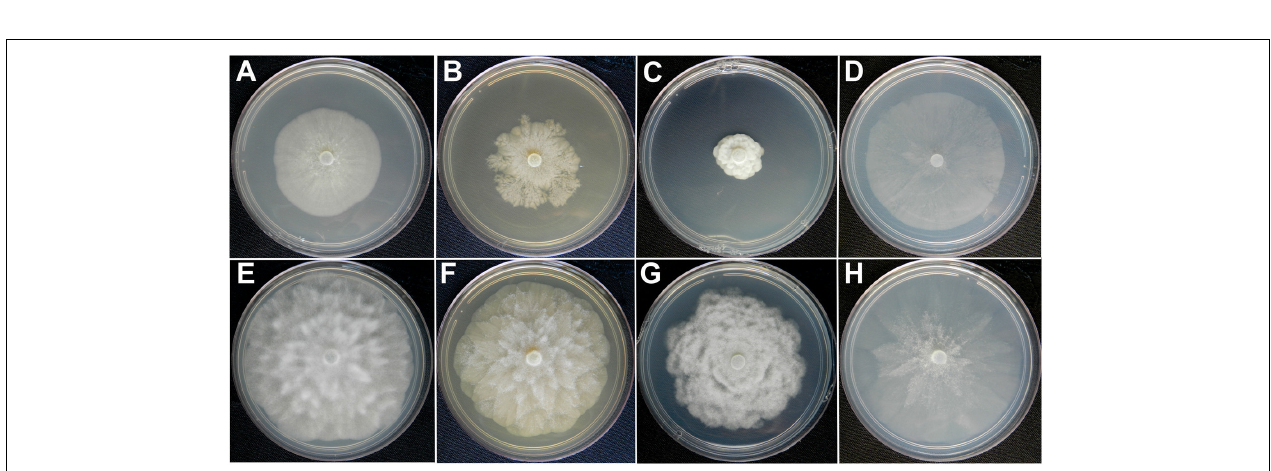
FIGURE 5 | Colony morphologies of Phytophthora palmivora (CCUB1102) and Phytophthora theobromicola (CCUB1091). Seven-day-old cultures of P. palmivora (A–D) and P. theobromicola (E–H) isolates grown on, from left to right, V8-juice-agar (V8A), 2% malt-extract-agar (MEA), potato-dextrose-agar (PDA), and carrot-agar (CA) at 20 ◦